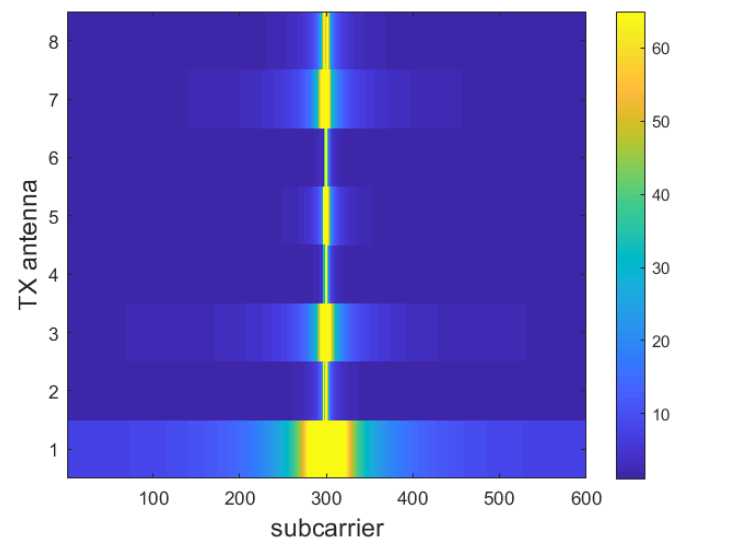
Figure 3. Module of channel matrix | H m | [32].